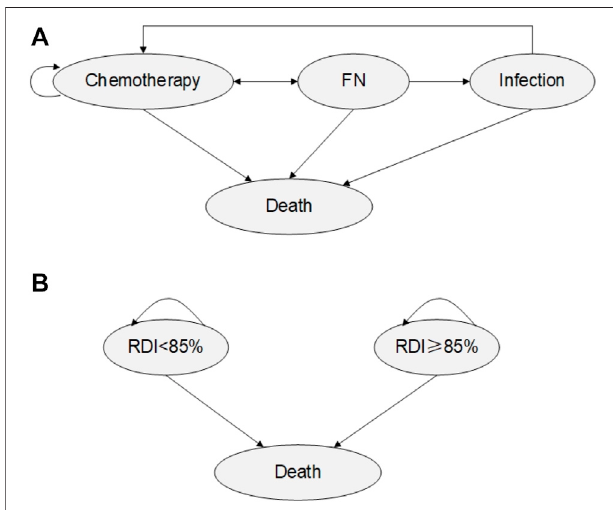
FIGURE1| ModelStructure (A) Model1:ChemotherapyMarkovModel. (B) Model 2: Post-chemotherapy Markov model.